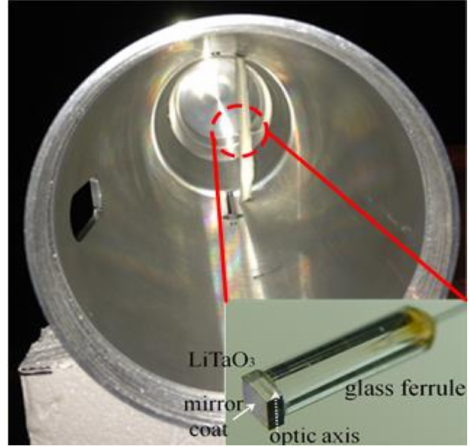
Figure 4. EO sensor probe in the GENEC